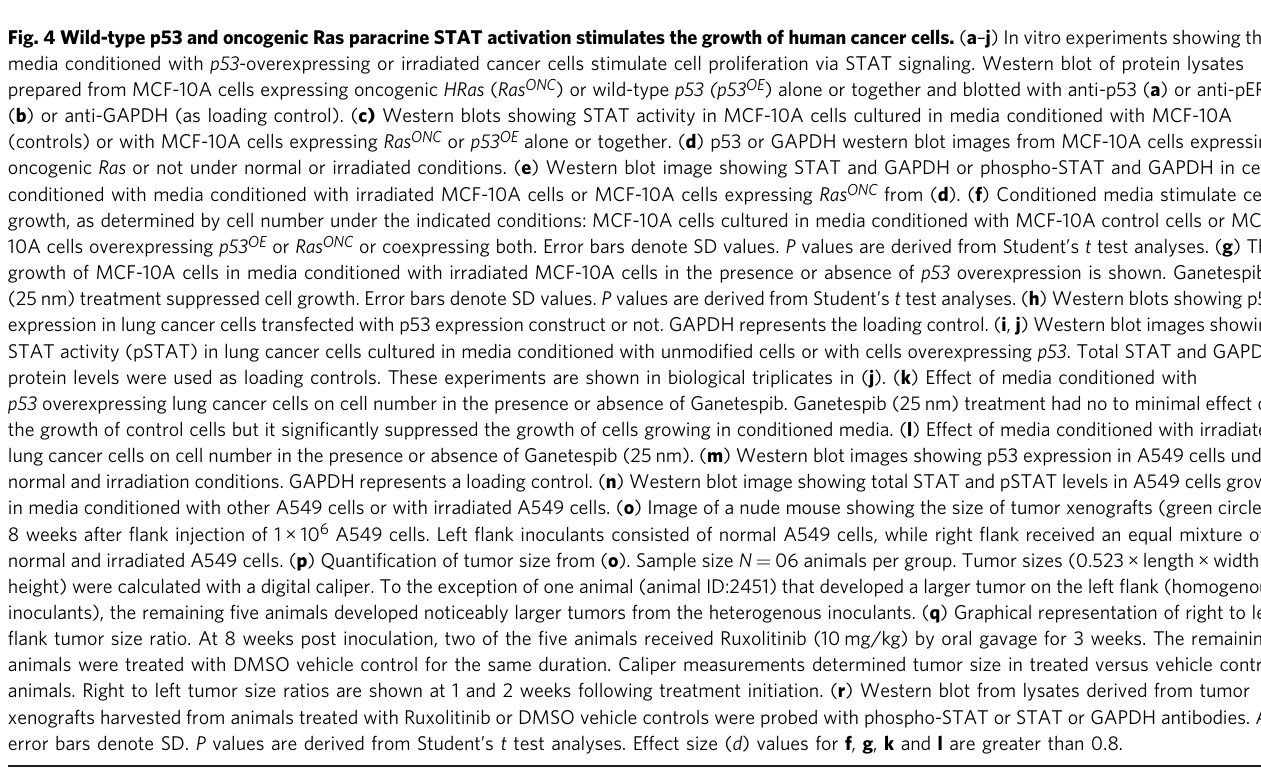
Fig. 4 Wild-type p53 and oncogenic Ras paracrine STAT activation stimulates the growth of human cancer cells. ( a – j ) In vitro experiments showing that media conditioned with p53 -overexpressing or irradiated cancer cells stimulate cell proliferation via STAT signaling. Western blot of protein lysates prepared from MCF-10A cells expressing oncogenic HRas ( Ras ONC ) or wild-type p53 (p53 OE ) alone or together and blotted with anti-p53 ( a ) or anti-pERK ( b ) or anti-GAPDH (as loading control). ( c) Western blots showing STAT activity in MCF-10A cells cultured in media conditioned with MCF-10A (controls) or with MCF-10A cells expressing Ras ONC or p53 OE alone or together. ( d ) p53 or GAPDH western blot images from MCF-10A cells